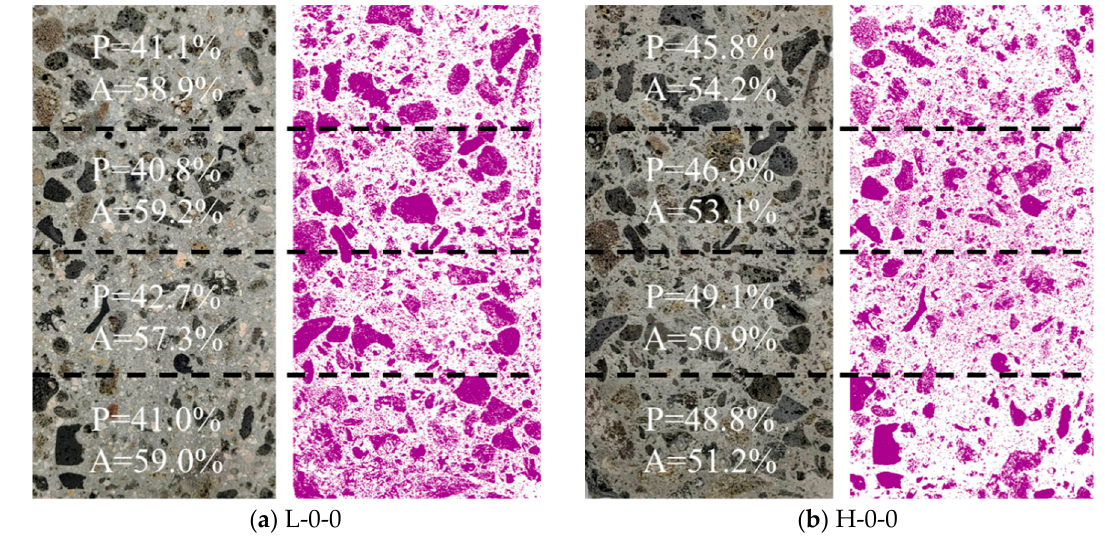
Figure 3. Distribution of lightweight aggregate particles with respect to the height of cylinder specimens (Note: P and A indicate cement matrix and bottom ash aggregate,